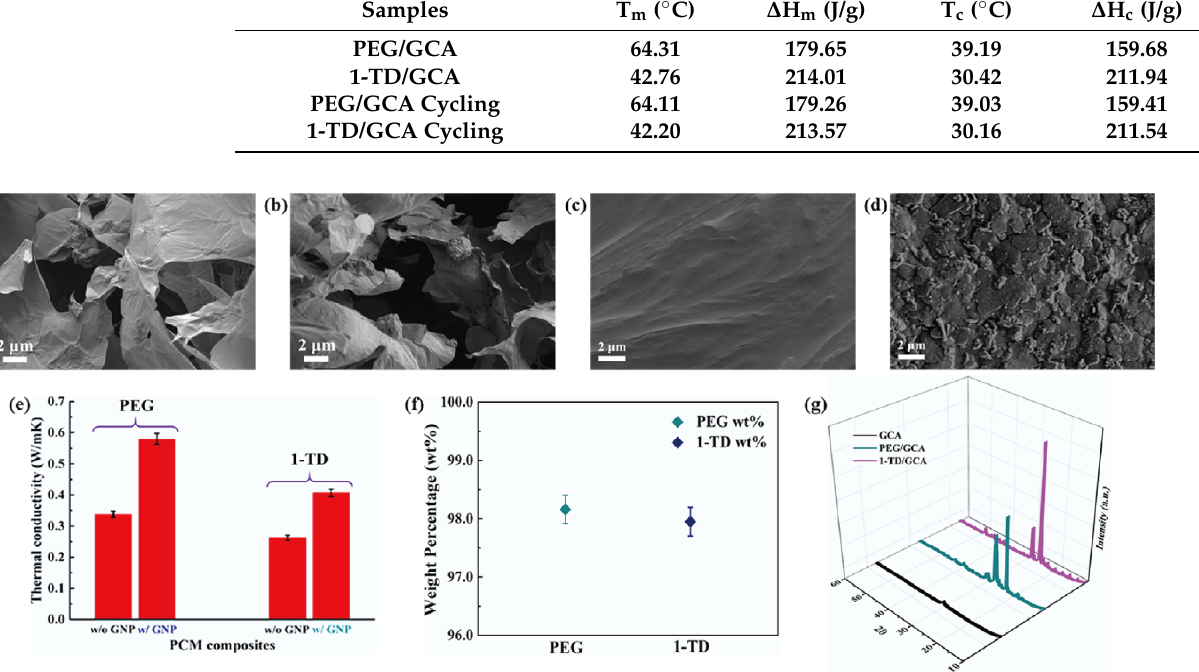
Figure 6. SEM images of ( a ) GCA 1:1, ( b ) GCA 1:2, ( c ) PEG/GCA composite, and ( d ) 1-TD/GCA composite. ( e ) Thermal conductivity of the PEG and 1-TD composites, and ( f ) the pure PCM weight fraction in the PCM composite. ( g ) XRD peaks of GCA, PEG/GCA, and